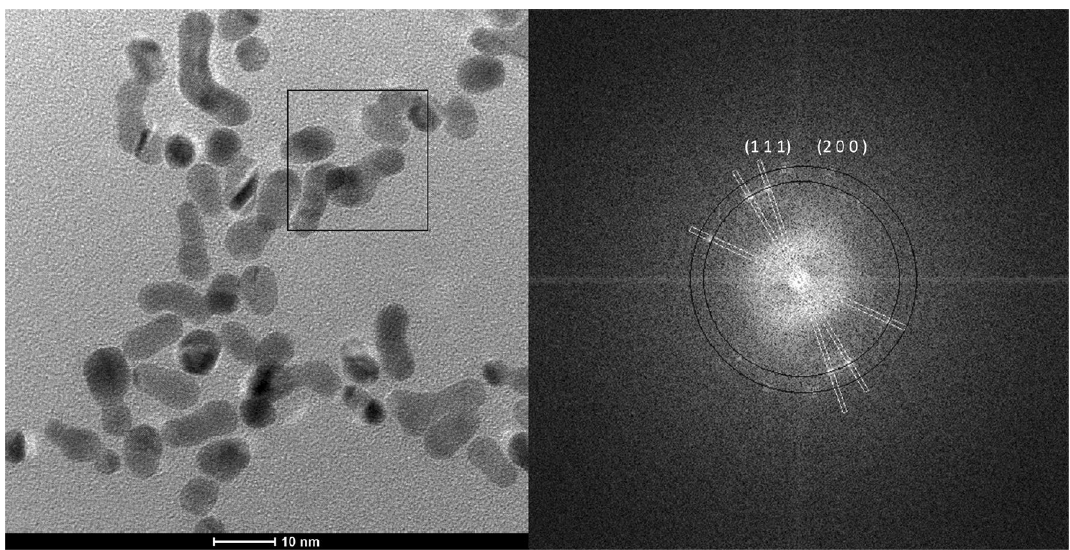
Figure 7. HR-TEM analysis of the PtNPs obtained in the microwave autoclave reactor at [Pt(IV)] = 1 × 10 −4